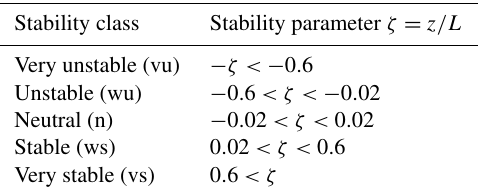
Table 3. In accordance with Table 1, the five reduced stability classes are